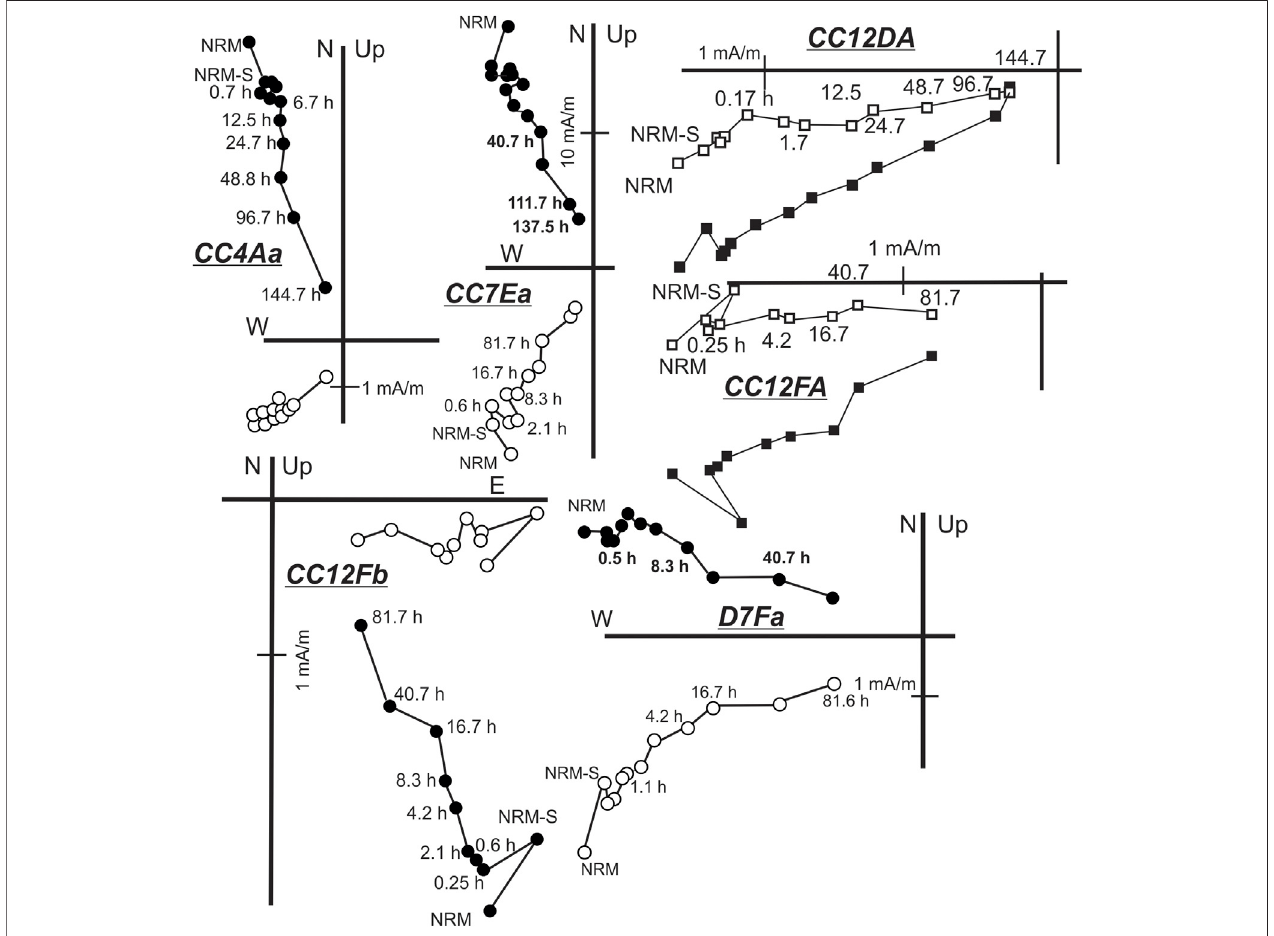
FIGURE 8 | Orthogonal progressive demagnetization diagrams (Zijderveld, 1967) showing the end point of the magnetization vector plotted onto the horizontal ( fi lled symbols) and vertical (open symbols) planes (NS-EW, EW-Up/Dn) for individual specimens from samples from selected sites at some of the northwest Texas sectionssampledforthisstudy.Specimenshavebeensubjectedtoprogressivechemicaldemagnetization.Selecteddemagnetizationstepsareshownfordatapointsin the horizontal projection.